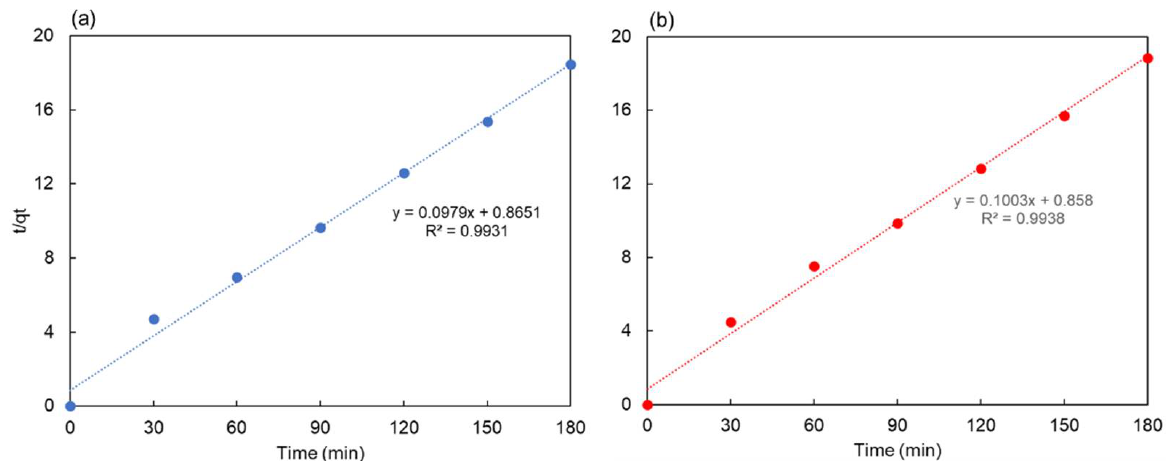
Figure 9. Pseudo second-order kinetics of STOn ( a ) and STOm ( b ).